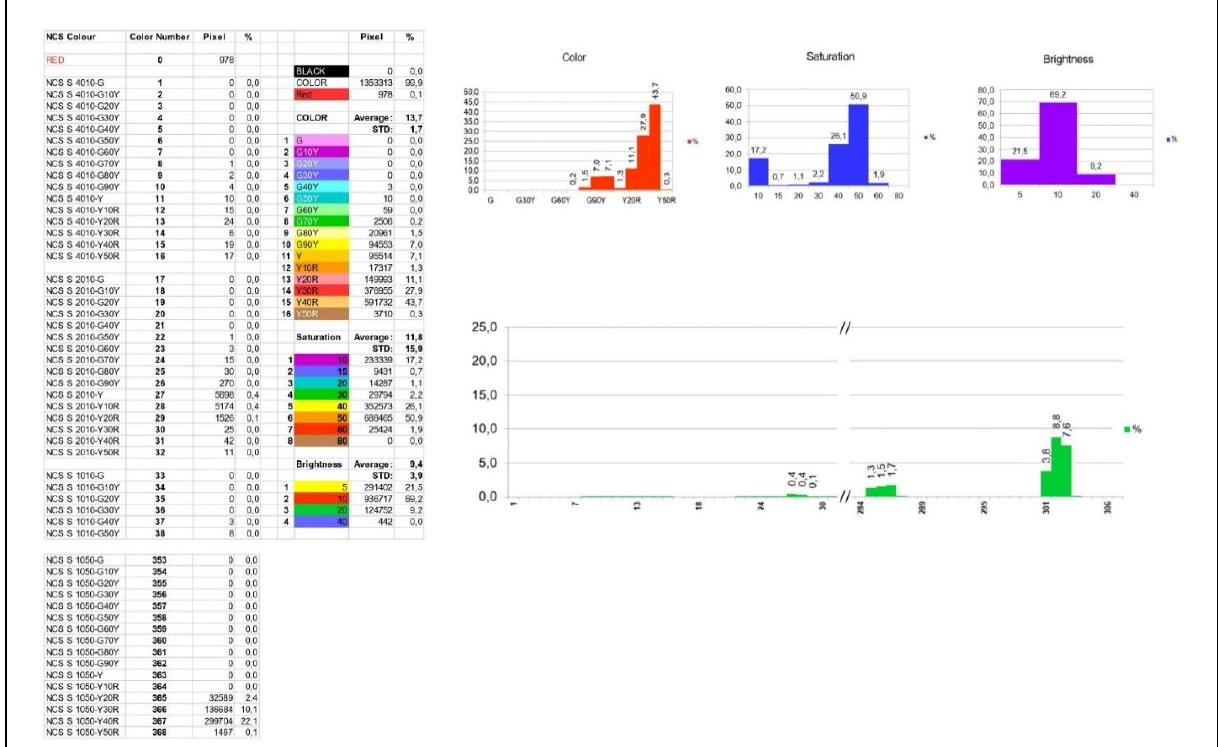
Figure 6. Exemplary data file as provided by the software WinFoodEval.